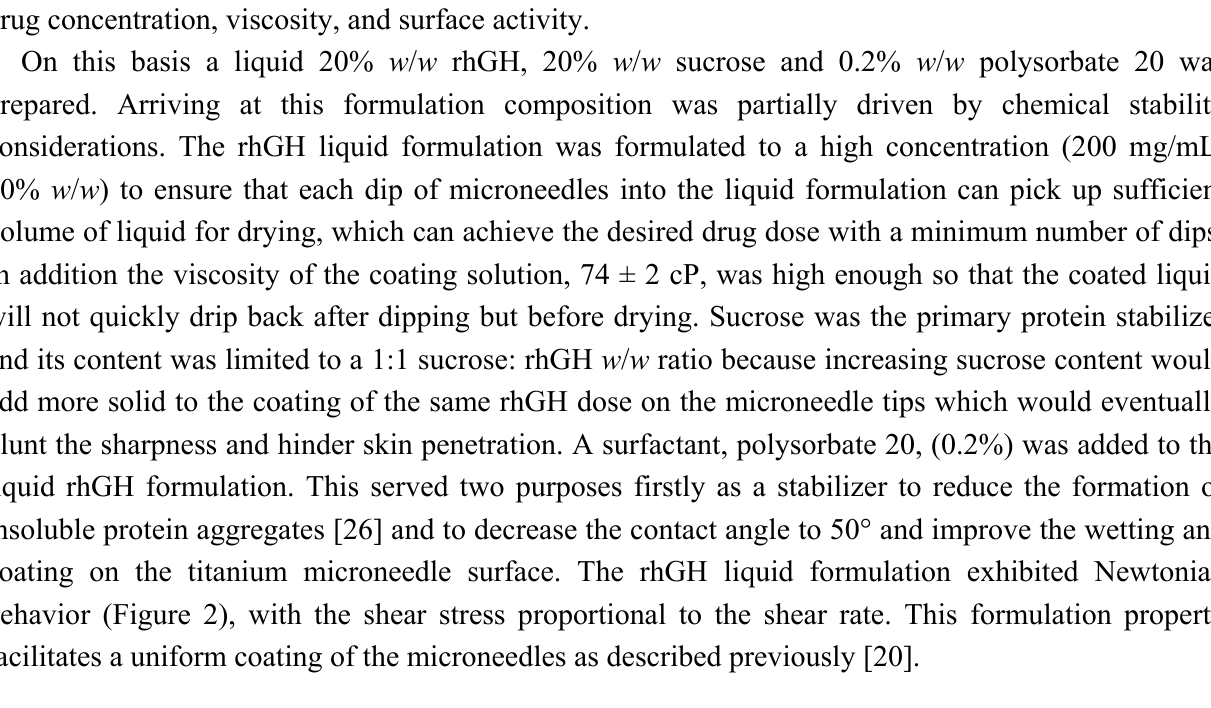
Figure 2. Shear stress vs. shear rate for 20% w / w rhGH, 20% w / w sucrose, 0.2% w / w polysorbate 20 liquid formulation. Shear stress is proportional to shear rate suggesting Newtonian behavior for the rhGH liquid